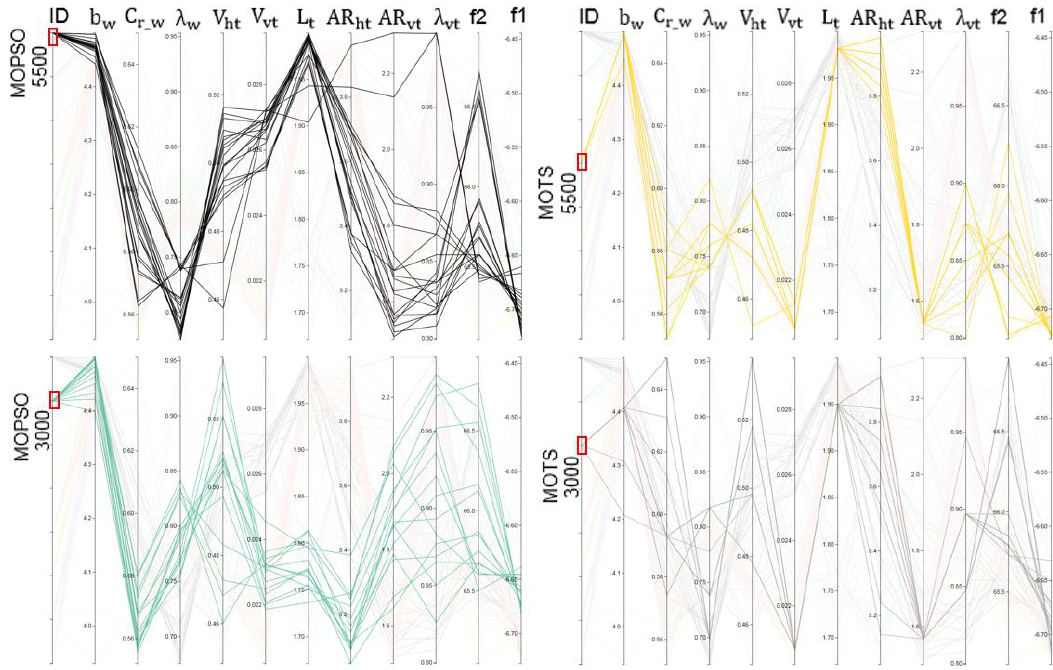
Figure 21. Objective functions as a result of wide particle spread across the entire design space in the case of non-interactive optimisation.